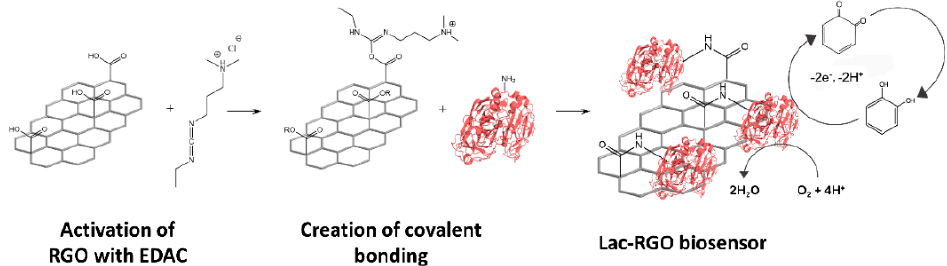
Figure 2. Scheme of the laccase immobilization. Step 1: activation of the RGO using EDAC (and NHS to increase the efficiency), Step 2: bonding creation between the primary amine from the enzyme and the intermediate complex of the RGO surface. Finally, the catalytic reaction is described.